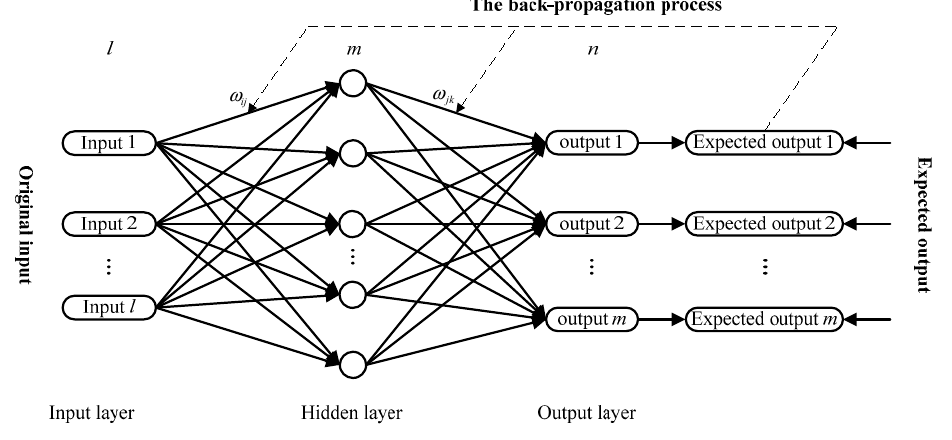
Figure 2. The basic structure of a three-layer BP neural network.